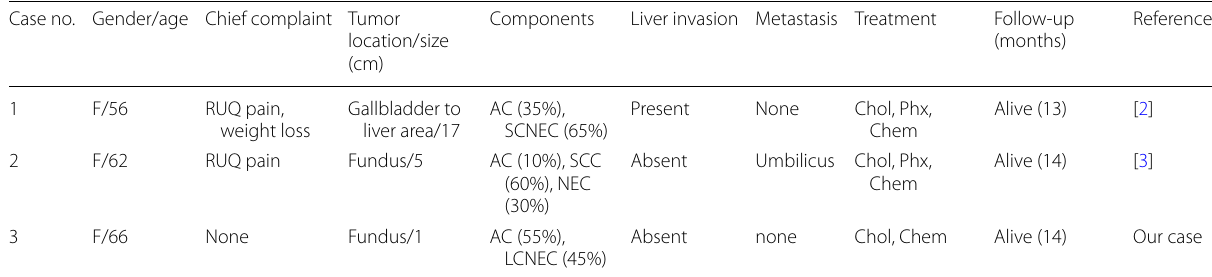
4). Adenocarcinoma component was located on the surface of × 40). Papillary and × 20). Neuroendocrine tumor cells arranged in nests. d Immunohistochemical staining ×